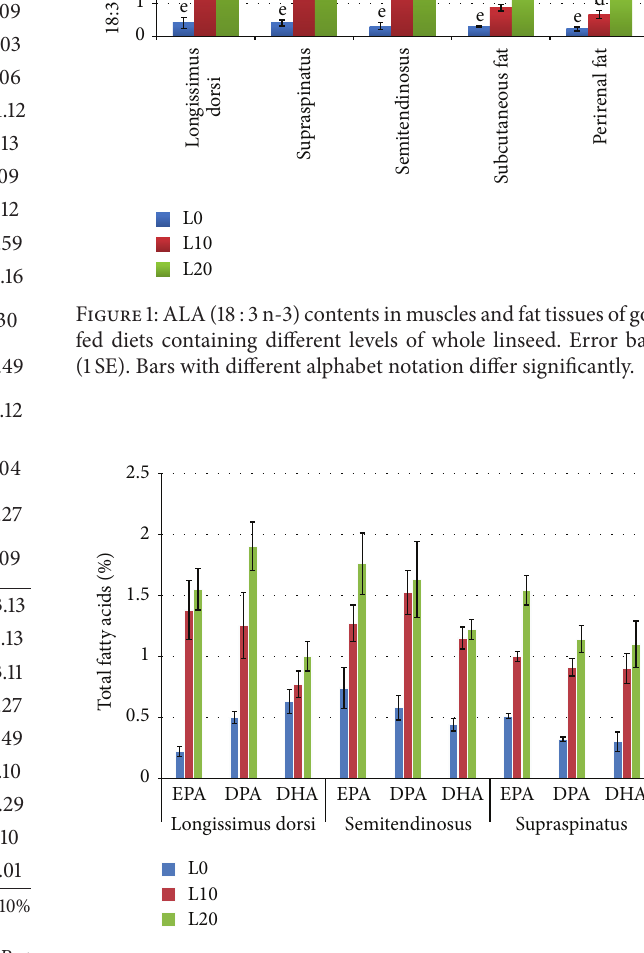
Figure 2: Long-chain n-3 FA contents in muscles and fat tissues of goats fed diets containing different levels of whole linseed. Error bar =